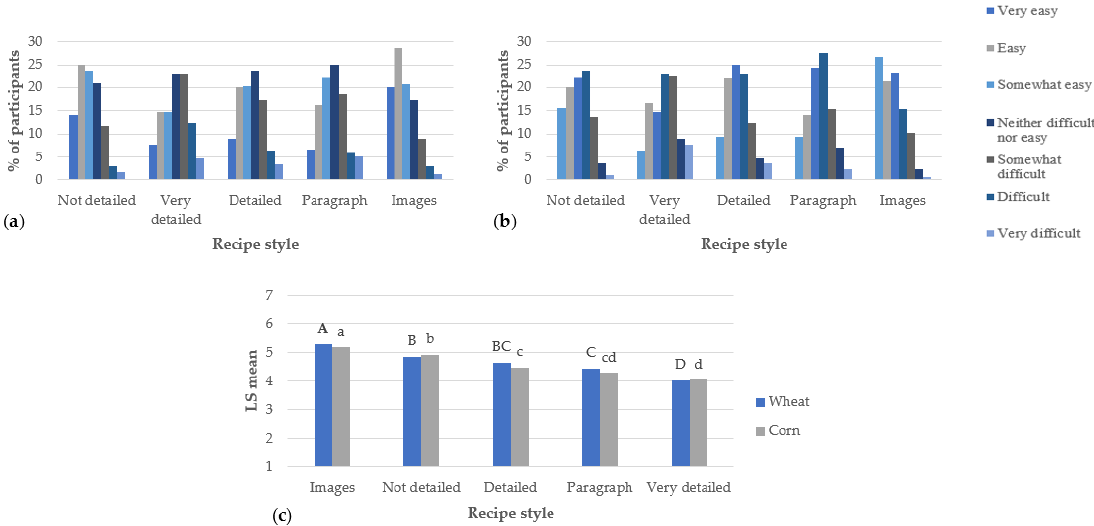
Figure 1. Easiness of the recipes presented to respondents (per study, n = 300), including ( a ) wheat study, ( b ) corn study, and ( c ) ANOVA. For the ANOVA, statistical comparisons are within wheat and corn recipes: bold, uppercase letters represent the wheat recipes; not bold, lowercase letters represent the corn recipes. Different letters among studies represent significantly different means ( p < 0.05).